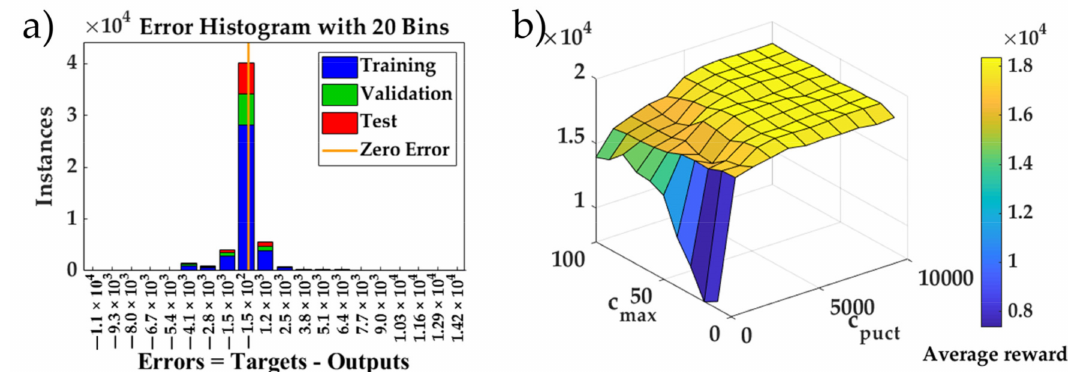
Figure 8. The results of the first generation of parking simulations combining MCTS with the policy network and value network: ( a ) The training error histogram distribution of the value network; and ( b ) the average reward over 25 initial parking positions for di ff erent MCTS